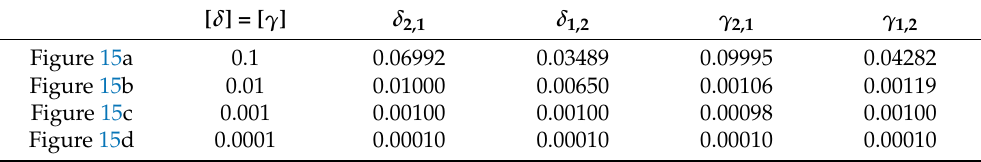
Table 6. Output and input coupling indices of the four design results shown in Figure